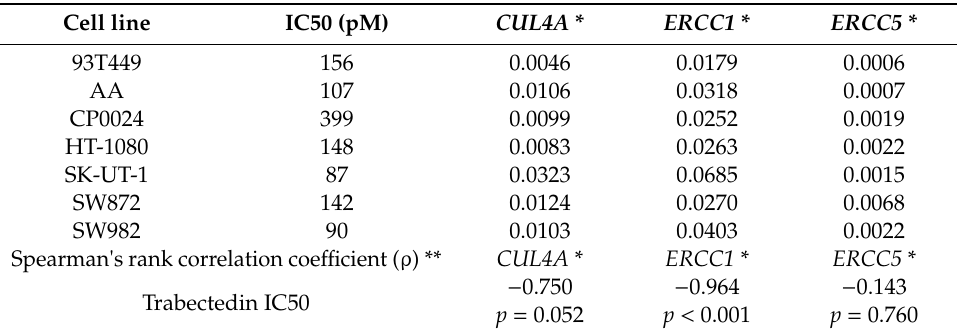
Table 4. Trabectedin IC50 and gene expression levels in soft-tissue sarcoma (STS) cell